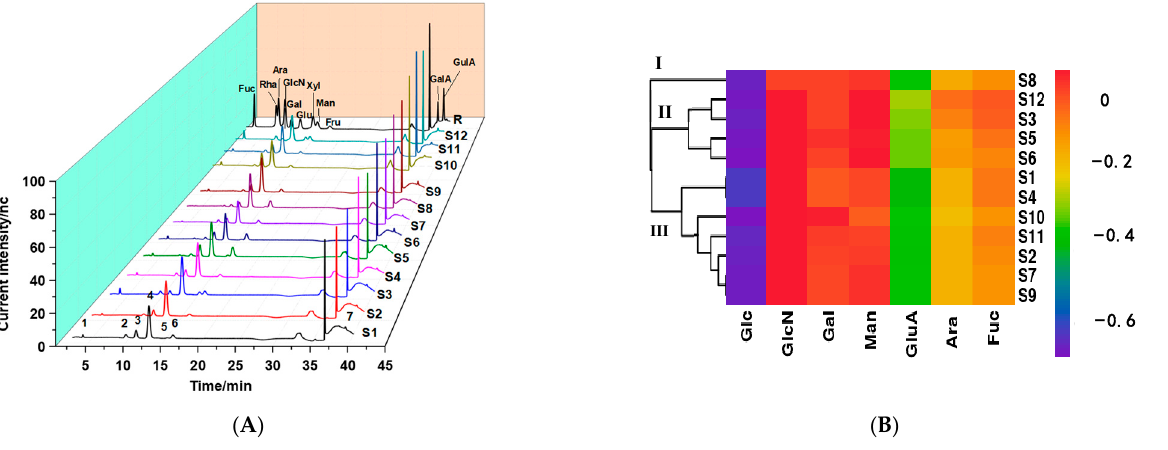
Figure 3. Monosaccharide composition of Ganoderma lucidum polysaccharides. HPAEC fingerprint ( A ), hierarchical cluster analysis of HPAEC fingerprint ( B ). 1: fucose, 2: arabinose, 3: glucosamine, 4: galactose, 5: glucose, 6: mannose, 7: glucuronic acid, R: standards pro fi le. Table 2. Monosaccharide composition and molar ratio of polysaccharides.